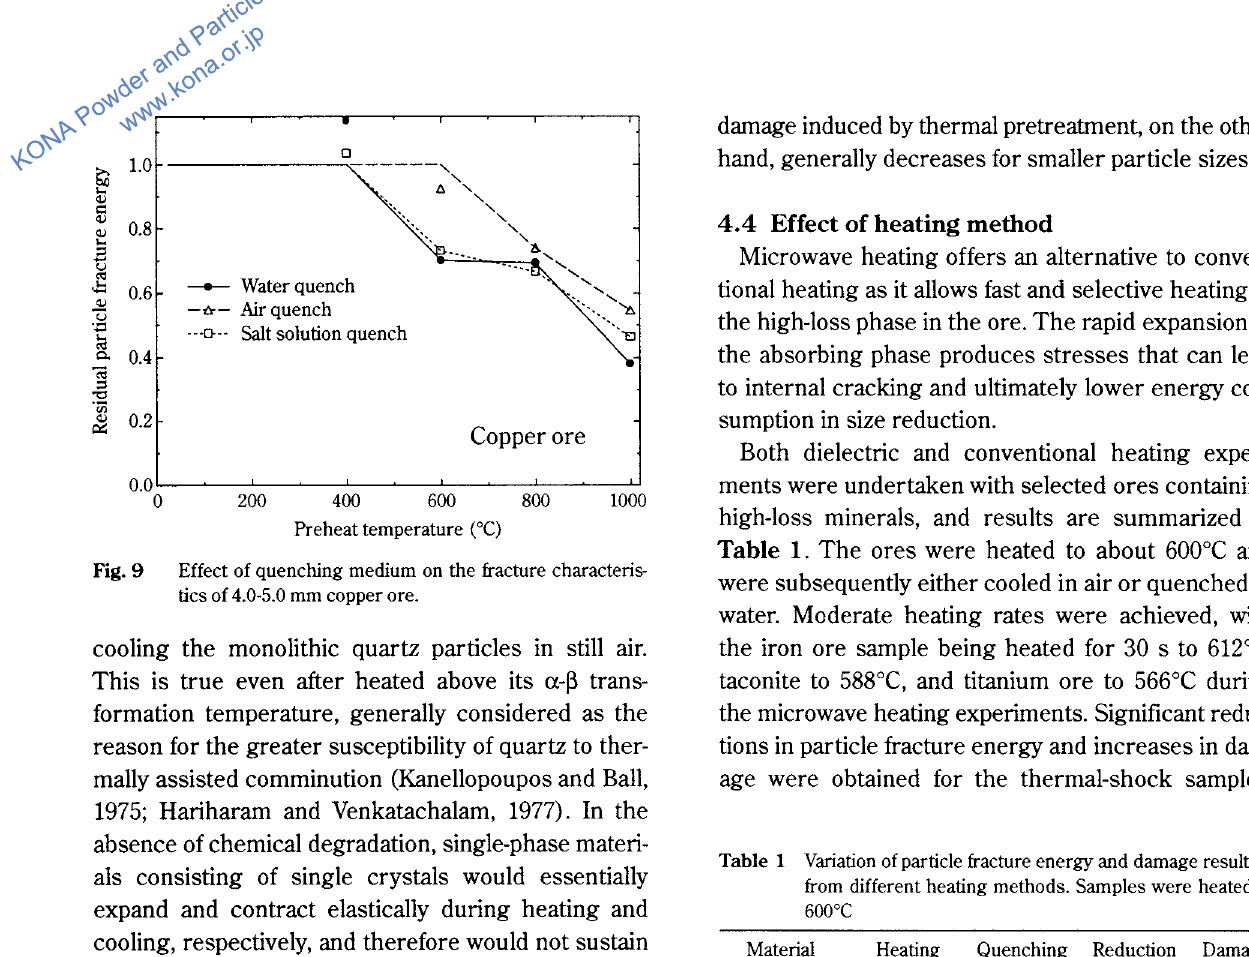
Table 1 Variation of particle fracture energy and damage resulting from different heating methods. Samples were heated to 600°C